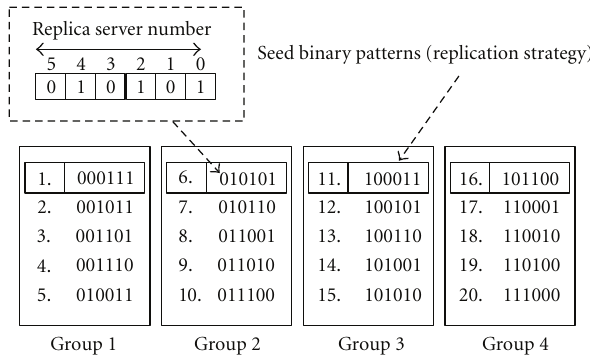
Figure 5: Example of replication strategy (ordering bit patterns), where n = 6 and k = 3, and division yields 4